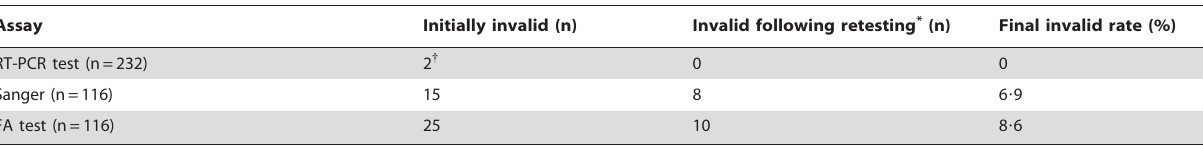
Table 2. Invalid test rates.